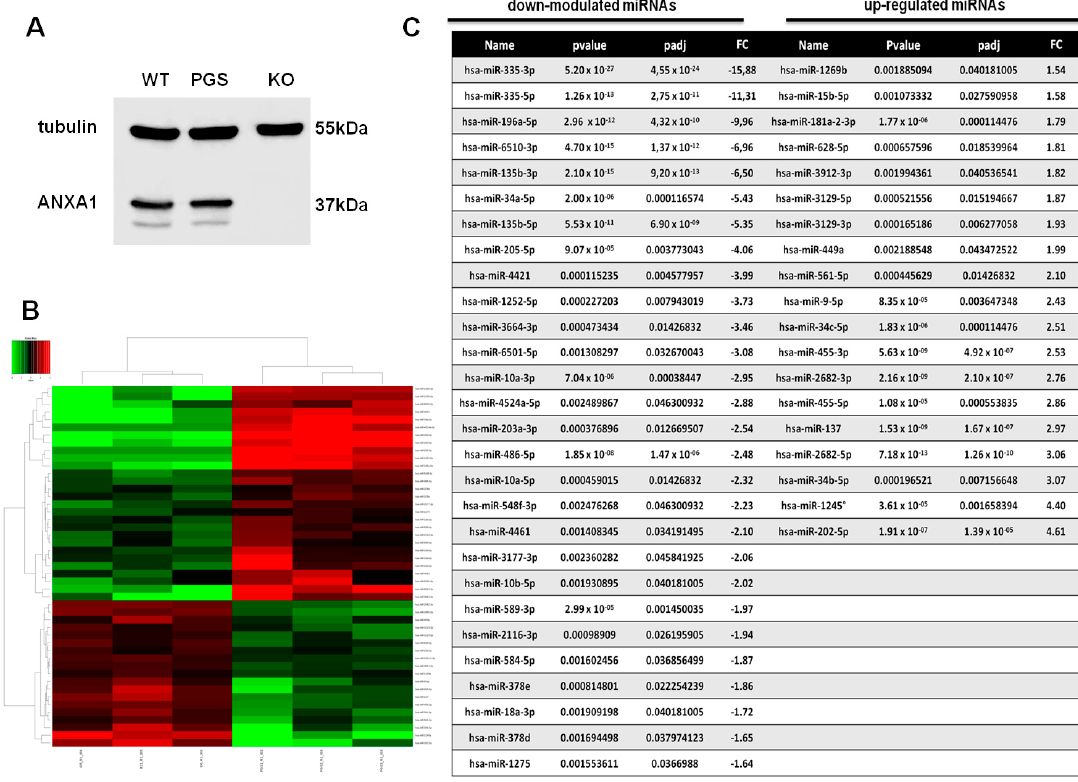
Figure 1. ( A ) Western blot of Annexin A1 (ANXA1) in wild type (WT), PGS MIA PaCa-2, and ANXA1 KO MIA PaCa-2 cells; ( B ) Heat map of the differential miRNA profile expression in PGS and ANXA1